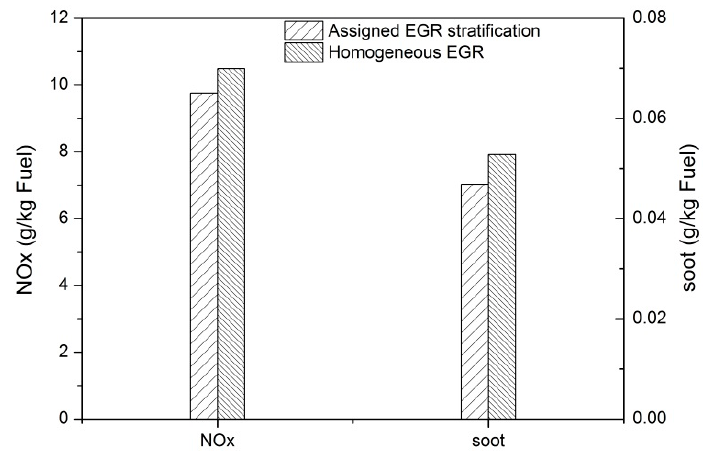
Figure 8. Comparison of engine-out NO x and soot between uniform EGR and assigned EGR stratification with equal mass of EGR in cylinder.